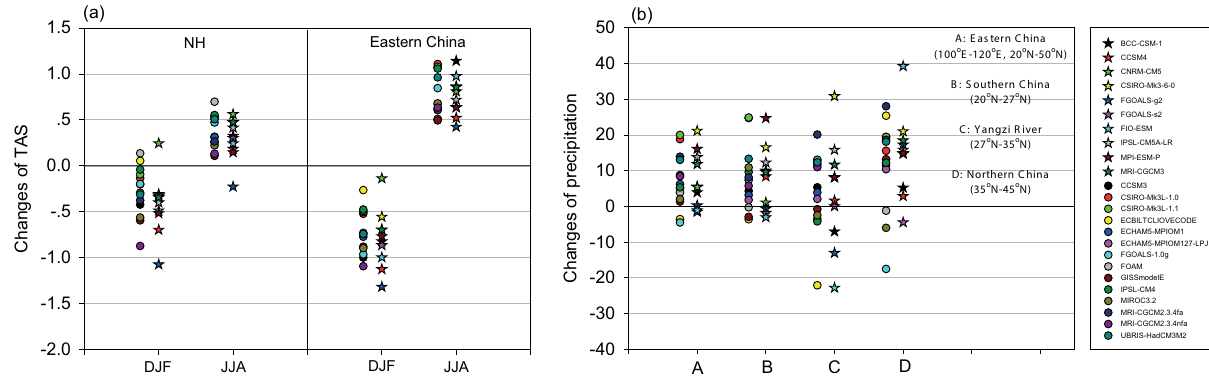
Fig. 5. (a) Changes of surface air temperature (TAS, ◦ C) in the Northern Hemisphere (NH) and Eastern China (100–120 ◦ E, 20–50 ◦ N) at 6ka for boreal winter (December–February, DJF) and summer (June–August, JJA); (b) changes of the summer monsoonal precipitation in Eastern China and its three sub-domains broadly divided by latitudes – Southern China (20–27 ◦ N), mid-lower reaches of Yangzi River (27–35 ◦ N) and Northern China (35–45 ◦ N). Star symbols indicate the results from PMIP3 models and the circles are for PMIP2 results. Different colours are used to distinguish the models within PMIP3 and PMIP2